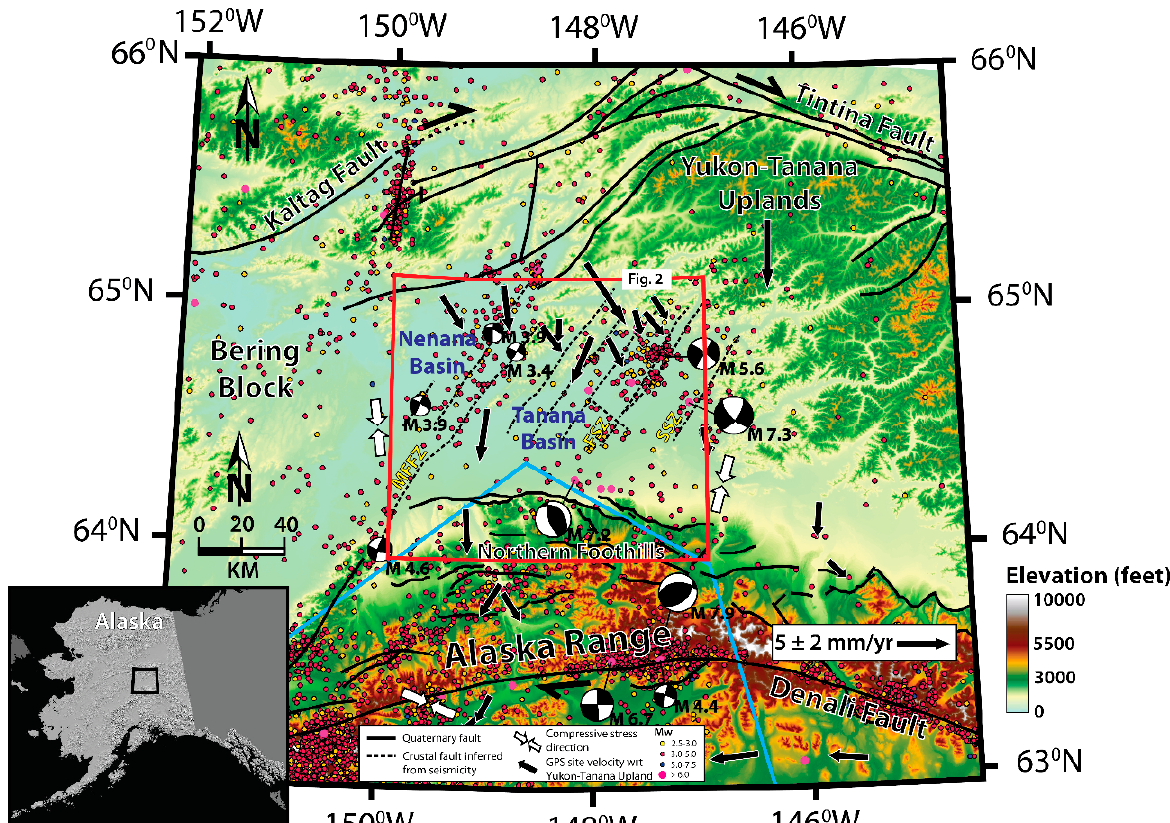
Figure 1. Simplified tectonic map of central Alaska showing the location of the study area relative to major active tectonic features and the major active faults in the region [7–10]. Red box indicates the position of Figure 2. The Minto Flats Seismic Zone (MFSZ), the Fairbanks Seismic Zone (FSZ), and the Salcha Seismic Zone (SSZ). The horizontal velocity vectors are measured relative to the stable North American craton and are inferred from the GPS velocities calculated for the region by Fletcher [5]. Focal mechanism solutions of notable earthquakes in interior Alaska indicate N–S directed compressive stresses in response to the plate subduction along the southern margin of Alaska [4,6,11]. The blue solid line marks the flat-slab region showing the subducted extent of the Yakutat microplate [6].